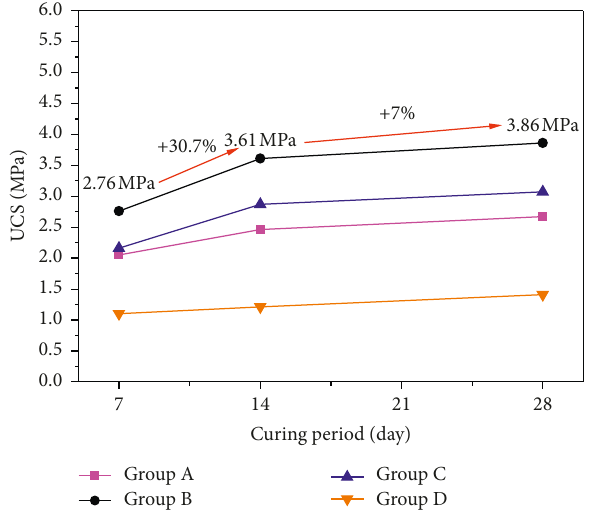
Figure 7: Curing age-UCS